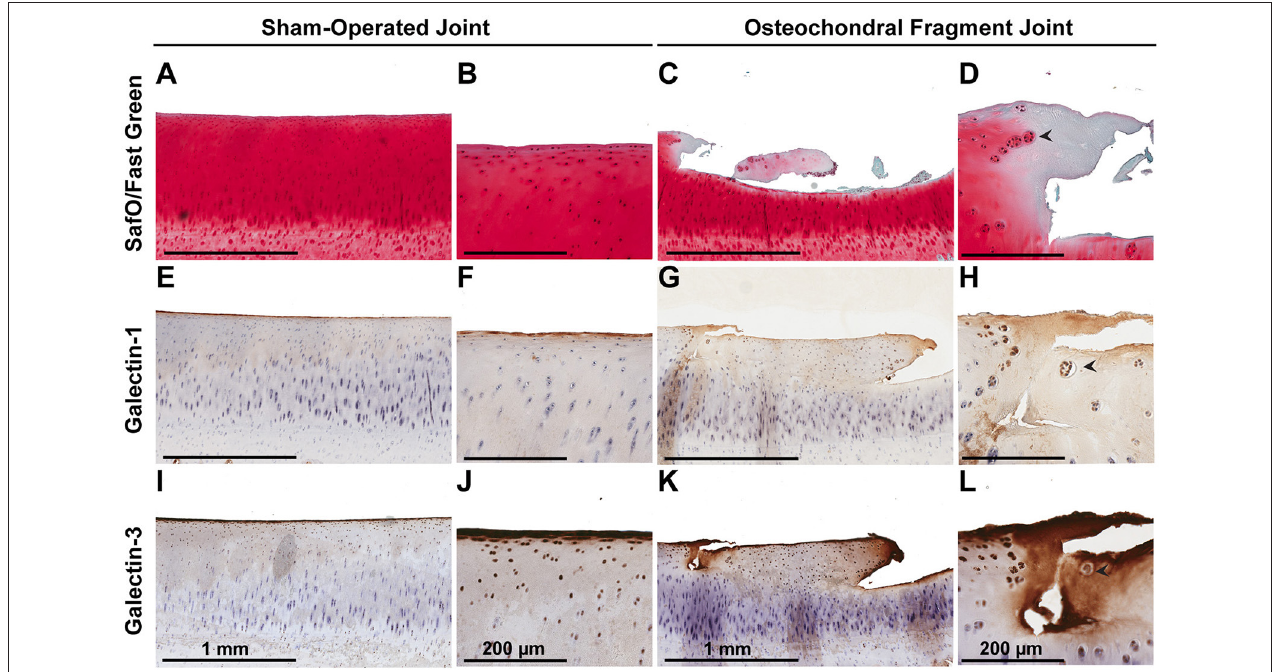
FIGURE 5 | Safranin O/Fast Green (A–D) , galectin-1 (E–H), and galectin-3 (I–L) immunostaining of third carpal bone cartilage from sham-operated and osteochondral fragment joints from a representative horse 70 days post-injury. Superficial zone chondrocytes and some middle zone chondrocytes stain positively for galectin-3 (I,J) but not galectin-1 (E,F) in sham-operated joints. Cartilage fibrillation, proteoglycan loss and chondrone (arrow) formation is observed in cartilage from the osteochondral fragment joint (C,D) . Chondrones stain positively for galectin-1 (G,H -arrow) and galectin-3 (K,L